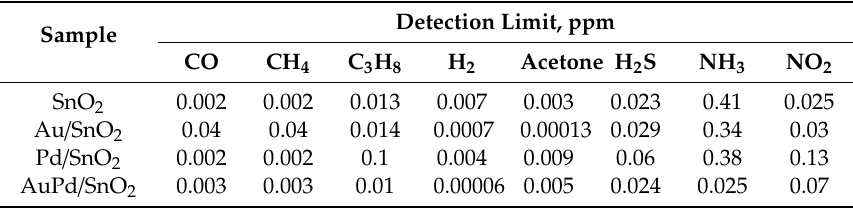
Table 3. Limits of detection of the sensors on the basis of the synthesized